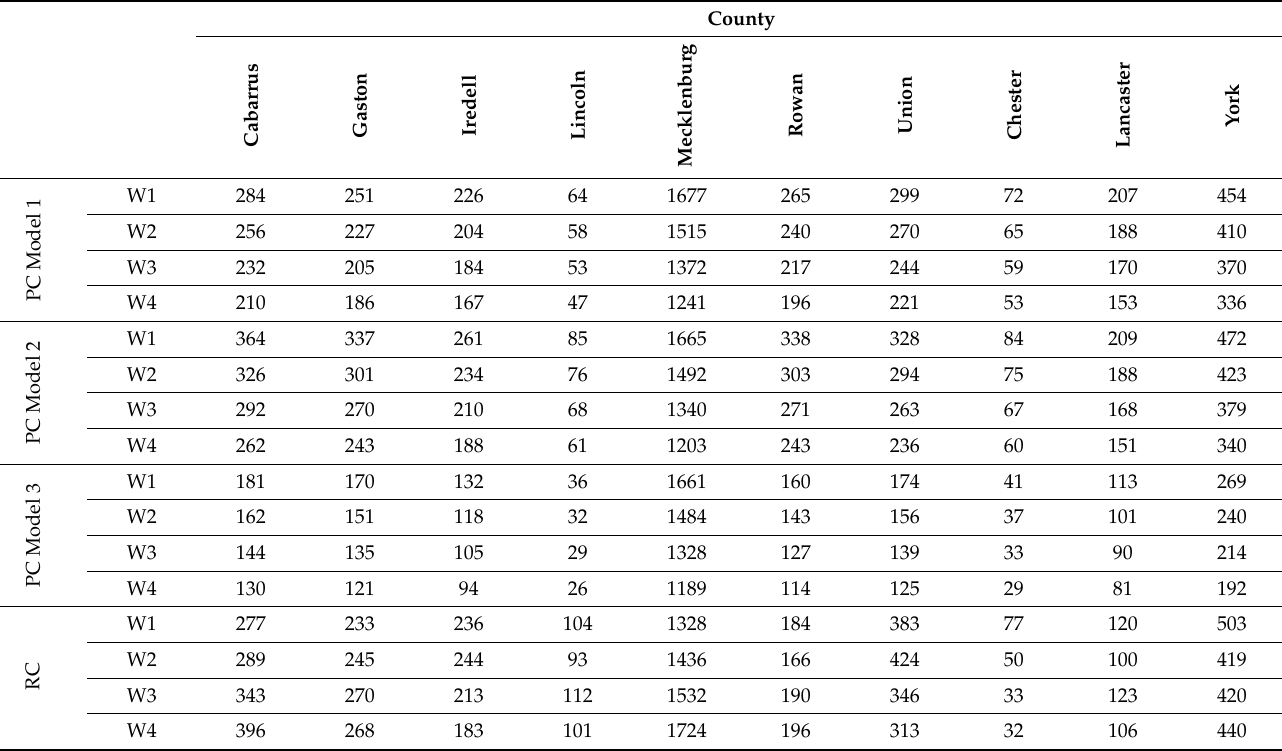
Table 3. Four-week predicted cases (PC) and reported cases (RC) across 10 counties in the MSA. County